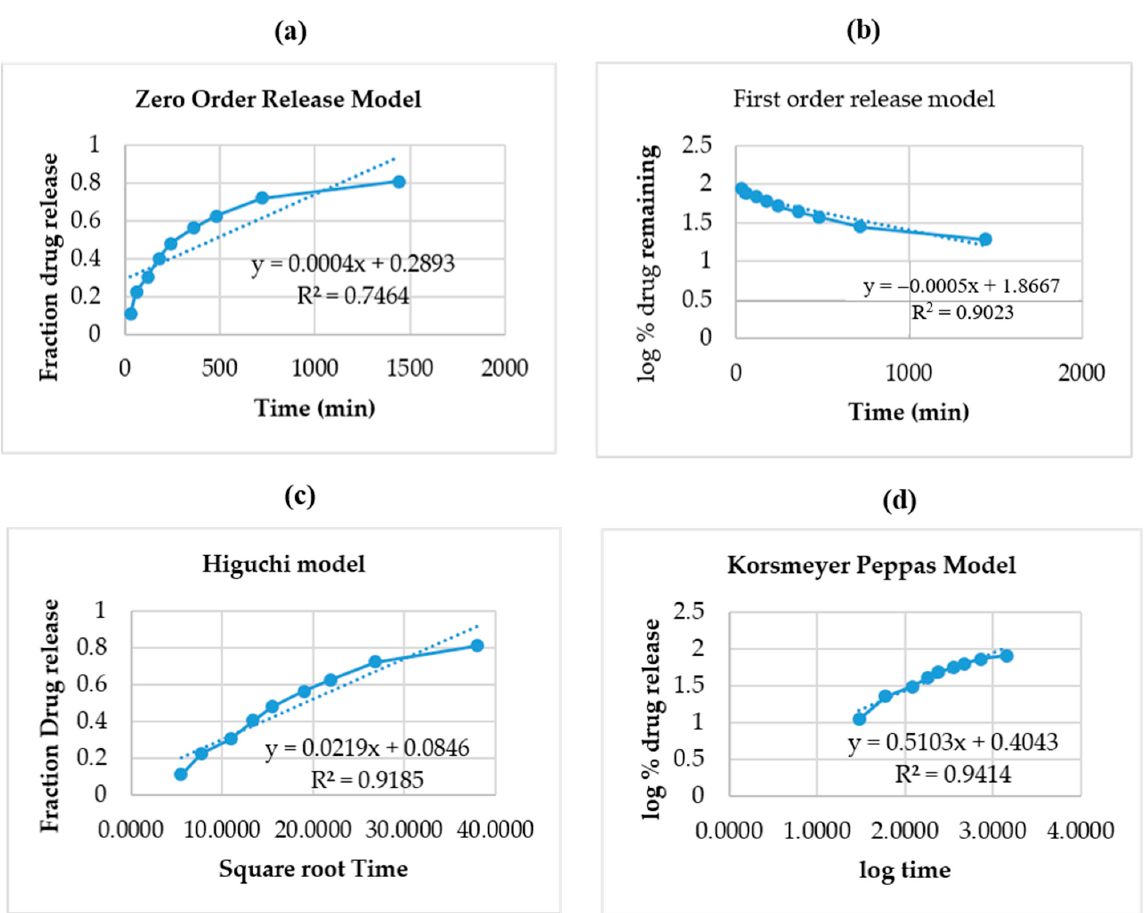
Figure 6. Different models used for in vitro release studies: ( a ) Zero order release model ( b ) First order release model ( c ) Higuchi model ( d ) Korsmeyer Peppas model.